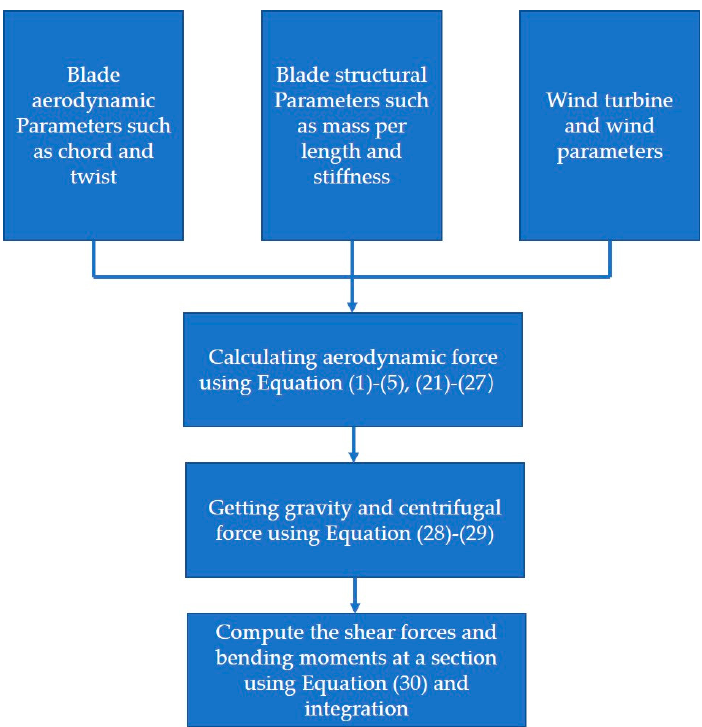
Figure 6. Flow chart of the blade load calculation model.